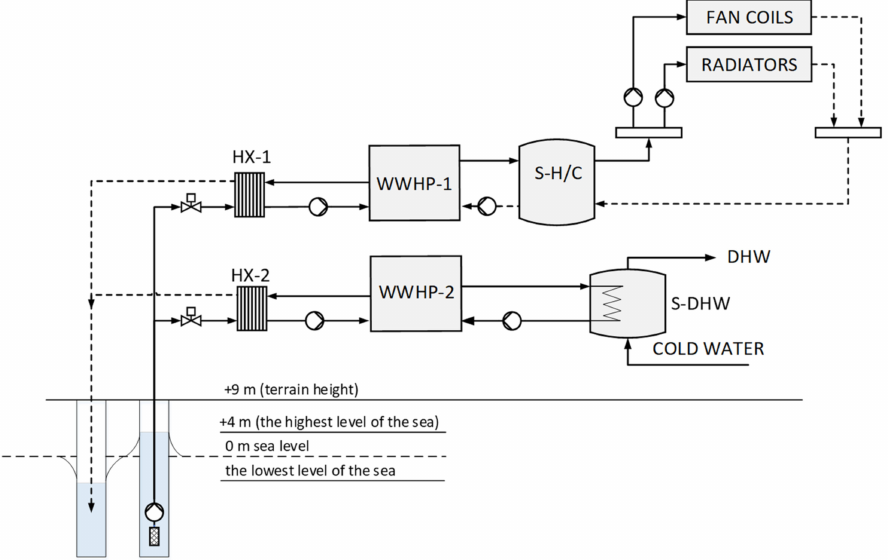
Figure 7. Scheme of HVAC system with WWHP